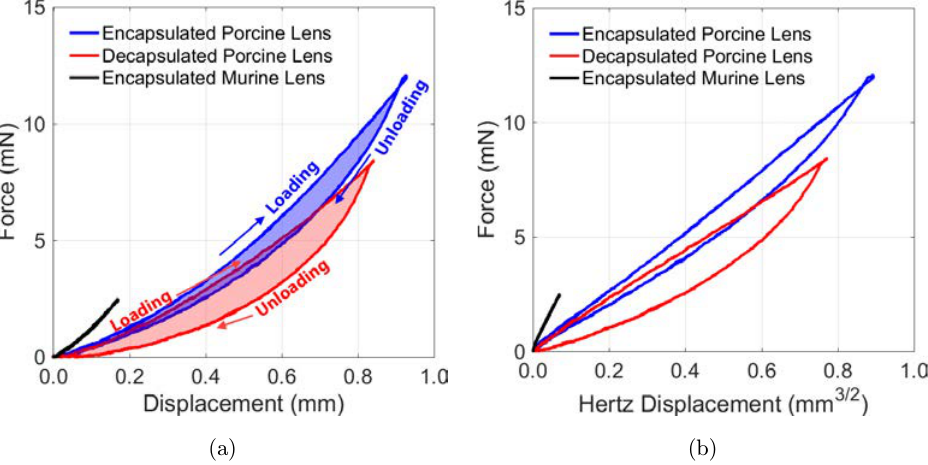
Fig. 3. (a) Force – displacement curves for the young porcine and adult murine lenses. The encapsulated porcine lens is sti®er and has less hysteresis than the decapsulated porcine lens. Note the nonlinear shape of the curve arising from variable contact area. (b) The role of contact area is clari¯ed by re-plotting the measurements in terms of the Hertz displacement (i.e., displacement raised to the 3/2 power), resulting in nearly straight lines for the loading